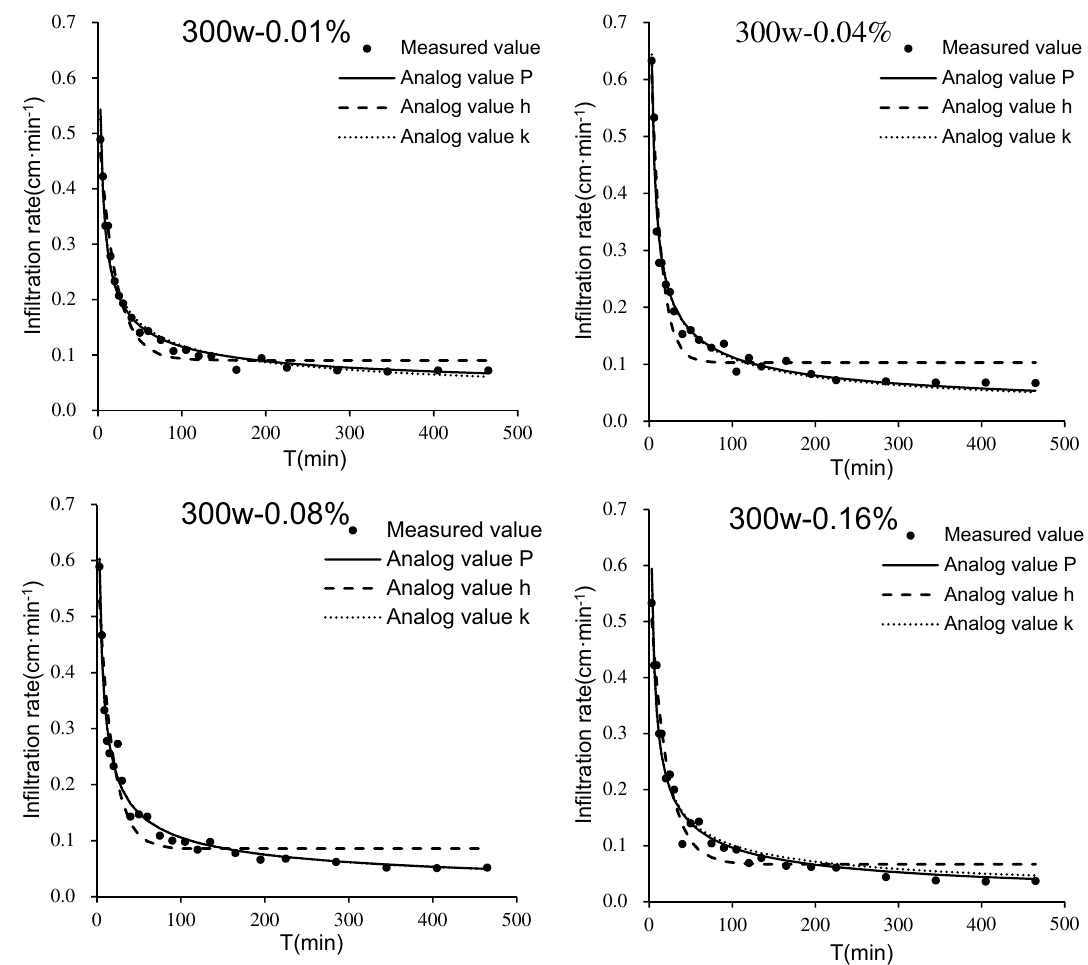
Figure 7. Infiltration model fitting of iron tailings for PAM molecular weight of 300w and four mass concentration (0.01%, 0.04%, 0.08% and 0.16%) of PAM. The measured value represents measured infiltration rate, the analog value P represents the Philip model fitting value of infiltration rate, the analog value h represents the Horton model fitting value of infiltration rate, and the analog value k represents the Kostiakov model fitting value of infiltration